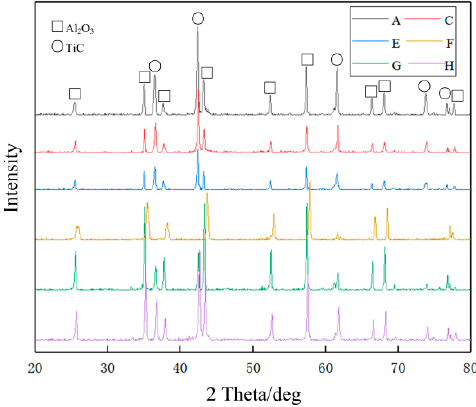
Figure 3. XRD spectra of composites A, C, E, F, G, and H.